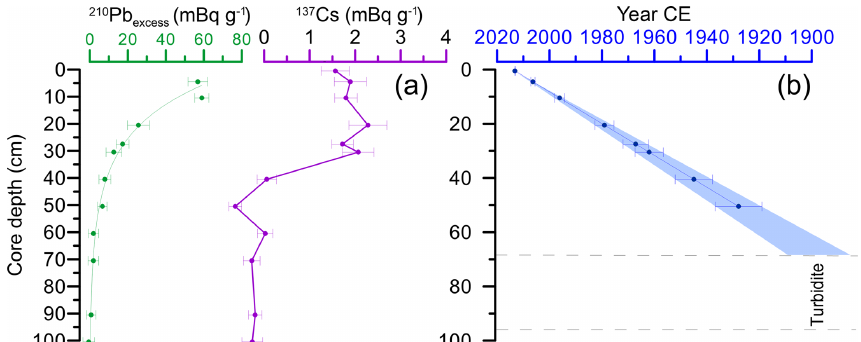
Figure 4. (a) Measurements of 210 Pb xs and 137 Cs in core POR13-05 according to core depth. (b) Age model calculated with the CS-CF